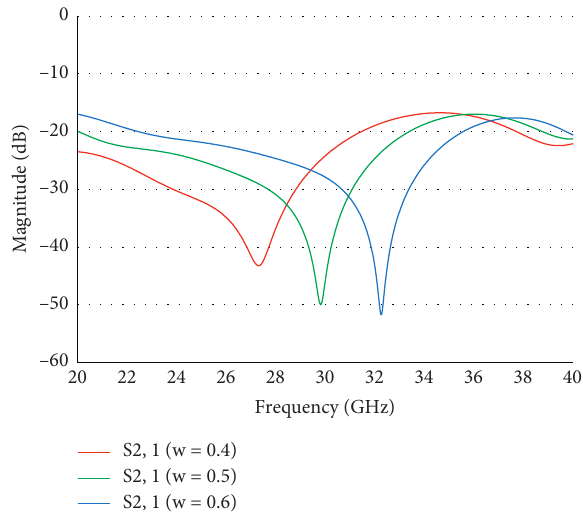
Figure 2: Effect of the “w” on